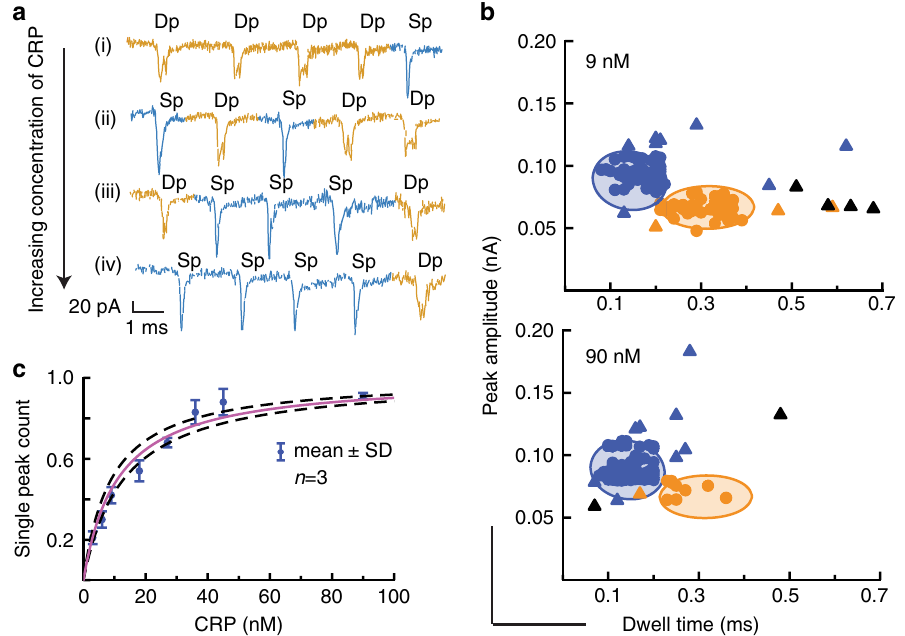
Fig. 3 CRP binding study. a Representative selection of ion current signatures for different CRP concentrations. The peak traces are stitched together from individual peaks of a longer trace to remove regions with no events for the purpose of illustration. b Translocation events of carriers (9 nM) incubated with different concentrations of CRP with their peak amplitude plotted against dwell time. The single peaks in the ion current data are coloured blue while the double peaks are coloured orange, and the unclassi fi ed events discarded from the quantitative analysis are represented as triangles. The plots are overlaid with the 95% con fi dence ellipses from Fig. S6a. c Normalised single peak count, i.e., ratio of single peaks vs total classi fi ed peaks against CRP concentration (Supplementary Tables 1 and 2). The data were fi tted with a Langmuir isotherm (solid line) and revealed a K d of 11 ± 2 nM. The dashed lines represent the con fi dence boundaries of the fi t. The error bars denote the standard deviation of translocation experiments conducted on different days using three different nanopipettes ( n = 3). The sampling time was 2 min for all concentrations. Source data are in the Source Data fi